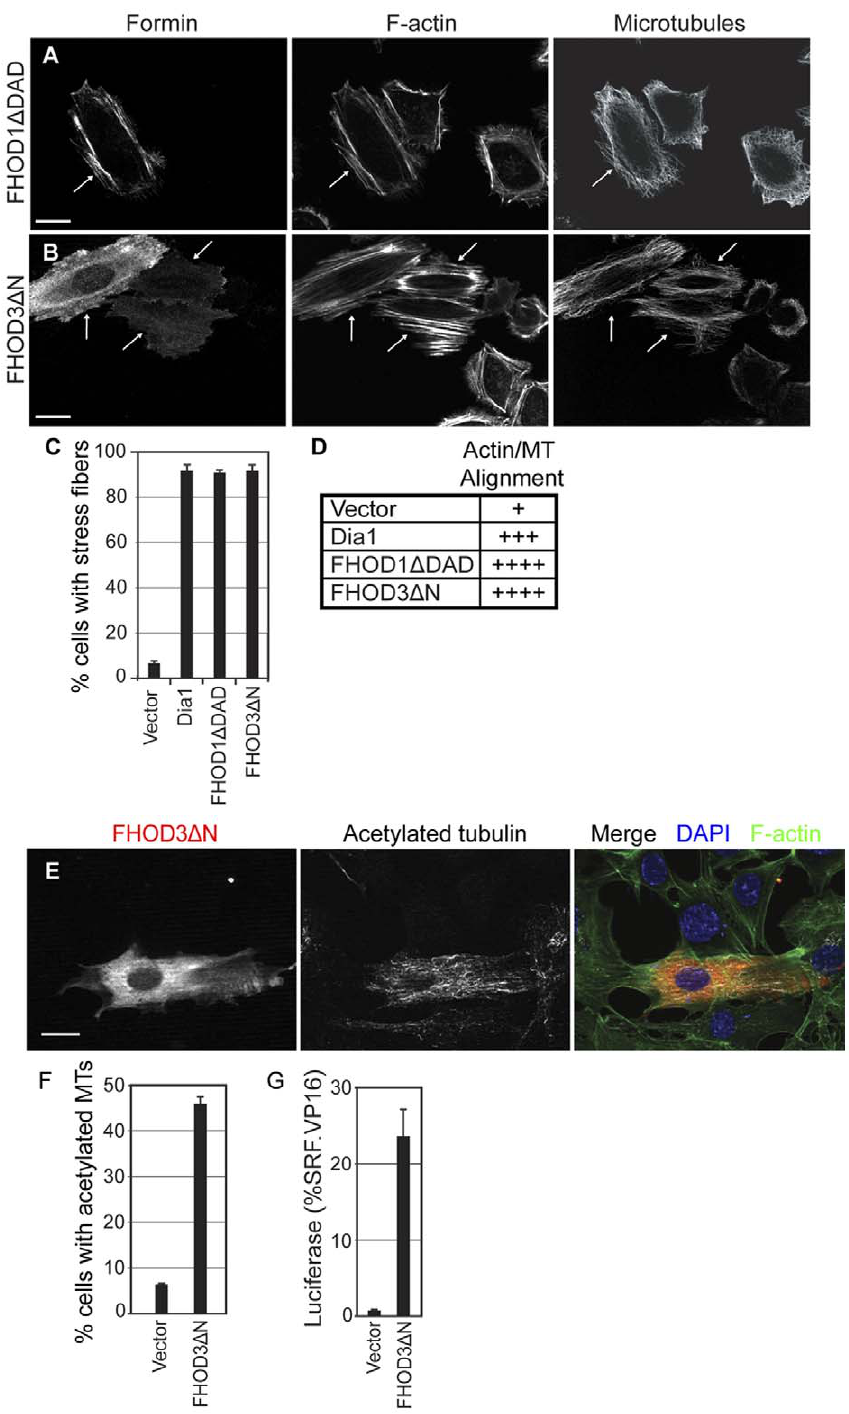
Figure 5. Larger derivatives of FHOD1 and FHOD3 induce stress fiber formation and co-alignment with microtubules. A, B ) FHOD1 D DAD and FHOD 3 D N were expressed in HeLa cells by transient transfection. Expression of either formin derivative (left panel) induced stress fiber formation (middle panel) and concomitant co-alignment with microtubules (right panel). C ) The number of transfected cells with increased stress fiber formation was determined by immunofluorescence. N=3, . 100 cells per sample, error bars represent SEM. D ) Summary of stress fiber and microtubule co-alignment. Dia1 FH1FH2 served as a positive control. E ) FHOD3 D N expression induces microtubule acetylation. FHOD3 D N expression (red, left panel) induces microtubule acetylation (white, middle panel) in NIH 3T3 fibroblasts. F-actin is also shown in the merged image (green, right panel). We were unable to obtain significant levels of expression of FHOD1 D DAD in NIH 3T3 cells. F ) Quantification of effects of FHOD3 D N expression on microtubule acetylation. The percent of transfected cells with increased microtubule acetylation was determined by immunofluorescence. N=5, . 100 cells per sample. Error bars represent SEM. G ) Expression of FHOD3 D N induces activation of an SRF reporter gene in NIH 3T3 fibroblasts (see Figure 3). N=3, error bars represent SEM.